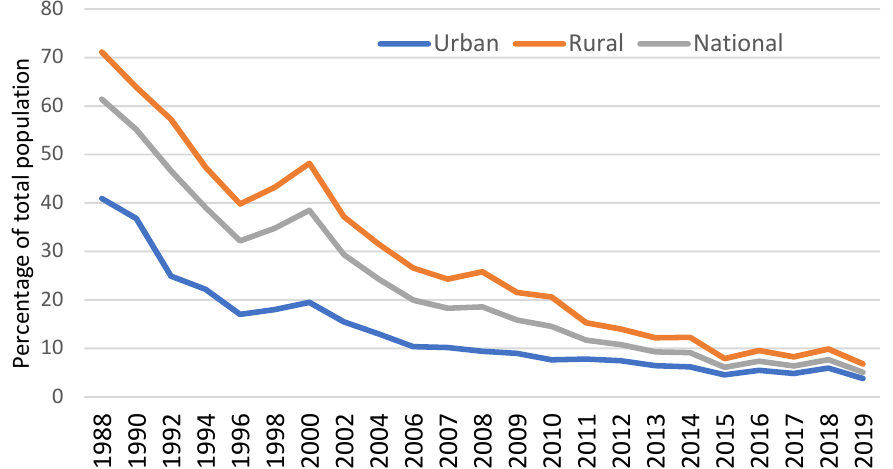
Figure 1. Proportion of Thailand’s population living below its national poverty line. Source: Thai- land’s NSO. Note: Thailand’s poverty line is calculated based on the minimum standard required by an individual to fulfill one’s basic food and non-food commodities. Details are provided in the NESDC report (2015).